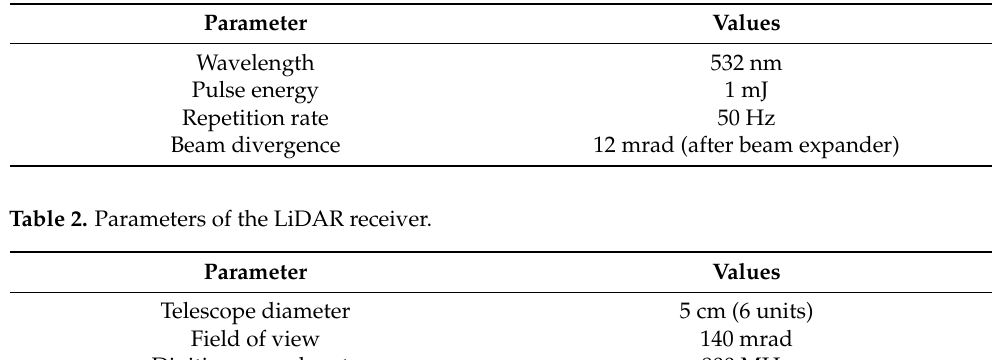
Table 1. Parameters of the LiDAR transmitter.